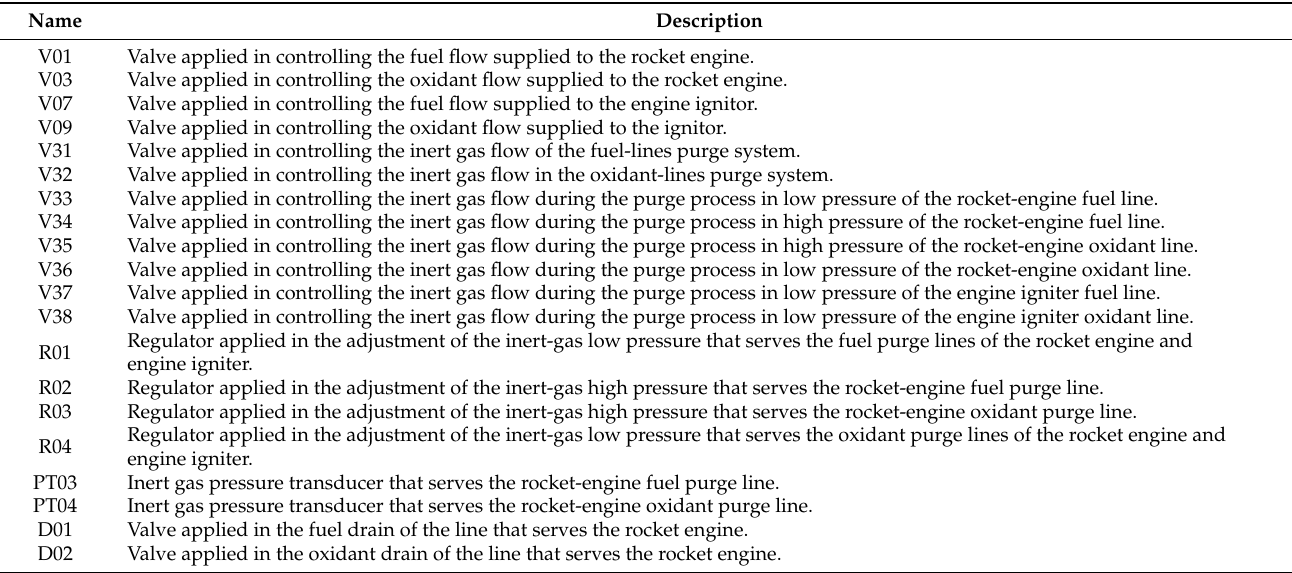
Table 1. Architecture elements.